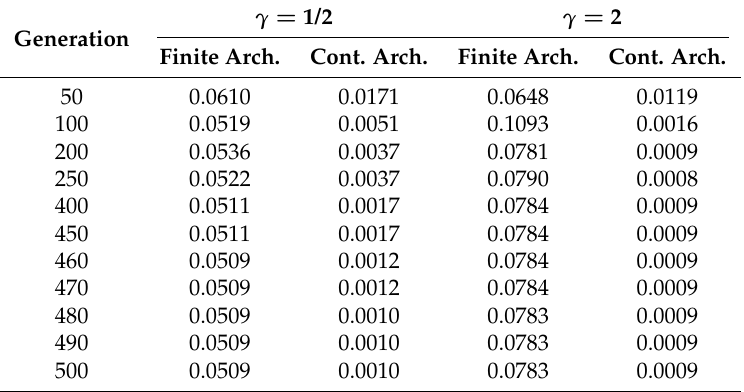
Table 8. For MOP (Equation (16)), the Table shows the ∆ p , q results for the finite and continuous Pareto front approximations. We used the MOEA/D generated archives for p = 1 and q = − 10.